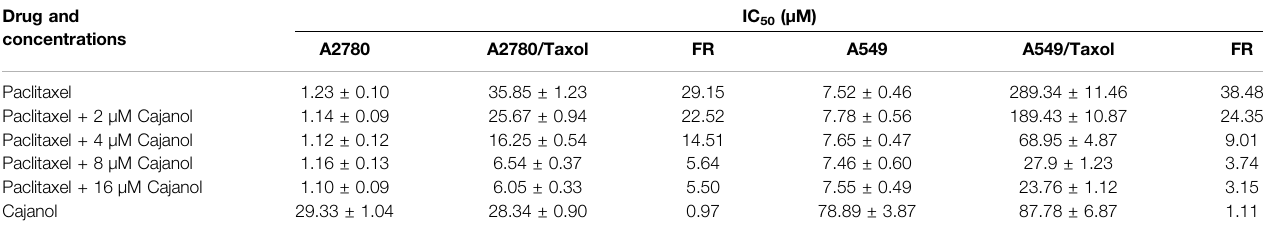
TABLE 1 | Effect of cajanol on the cytotoxicity of paclitaxel in A2780/Taxol and A2780 cells by MTT assay. Drug and concentrations